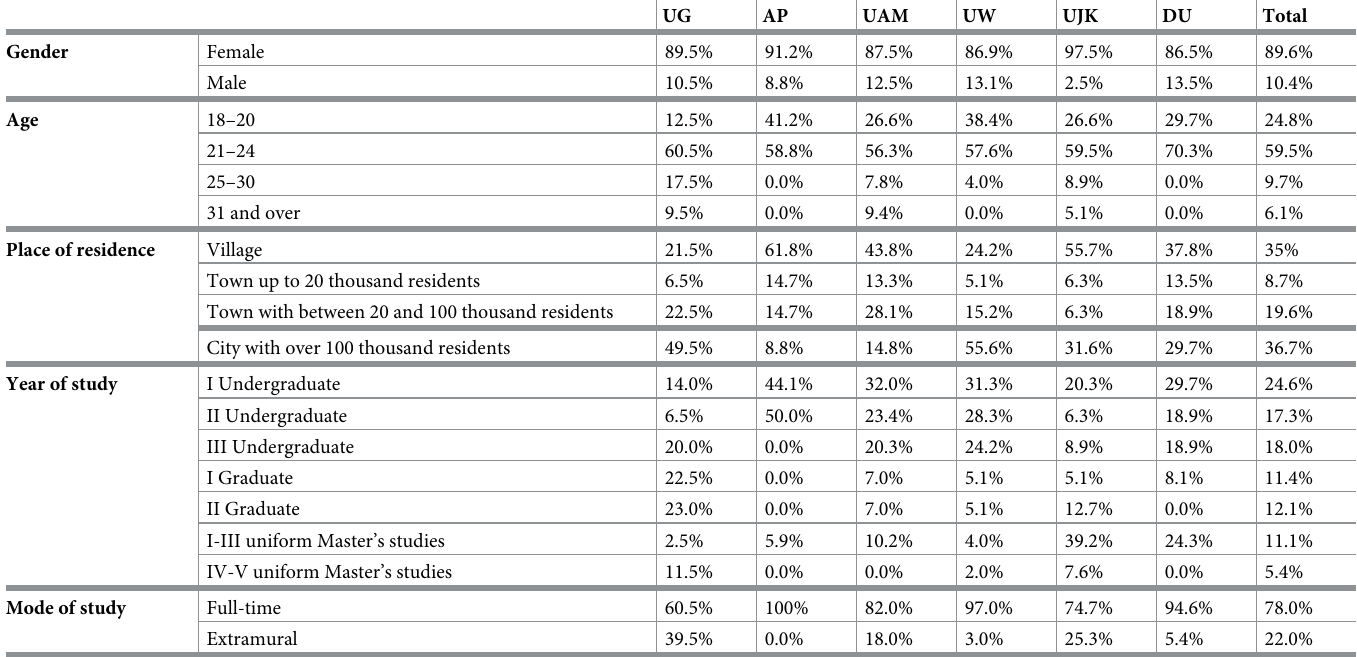
Table 1. Sociodemographic characteristics of the sample.